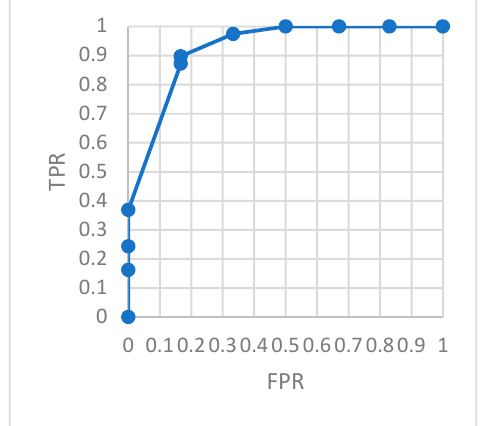
Figure 18. ROC of AutoEncoder in test set 1.